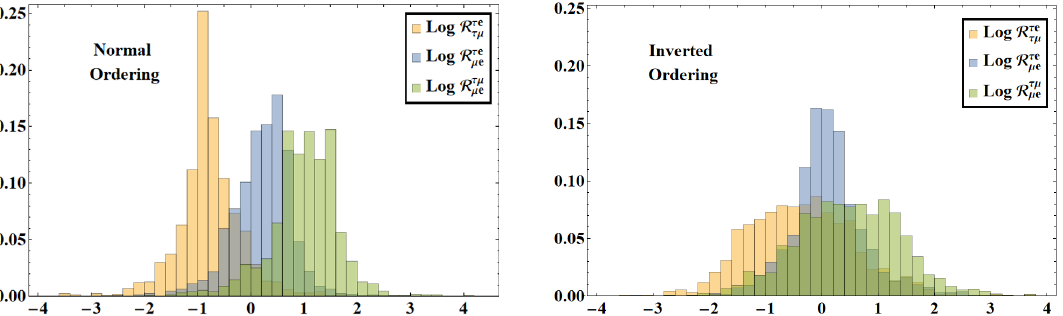
Figure 5 . Density histograms for the ratios of the branching ratios R ‘ i ‘ j for IO on the right. In orange R τe allowed by the present experimental bounds and by the perturbativity condition.